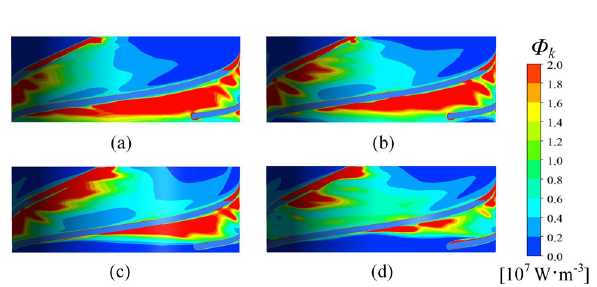
Figure 7. Distribution of the volume enstrophy dissipation rate at 0.95 span. ( a ) 80 m 3 ∙h −1 , ( b ) 90 m 3 ∙h −1 , ( c ) 100 m 3 ∙h −1 , and ( d ) 110 m 3 ∙h −1 .